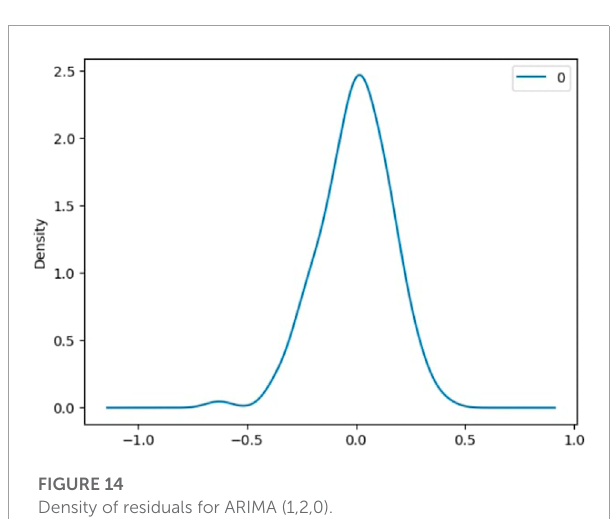
FIGURE 14 Density of residuals for ARIMA